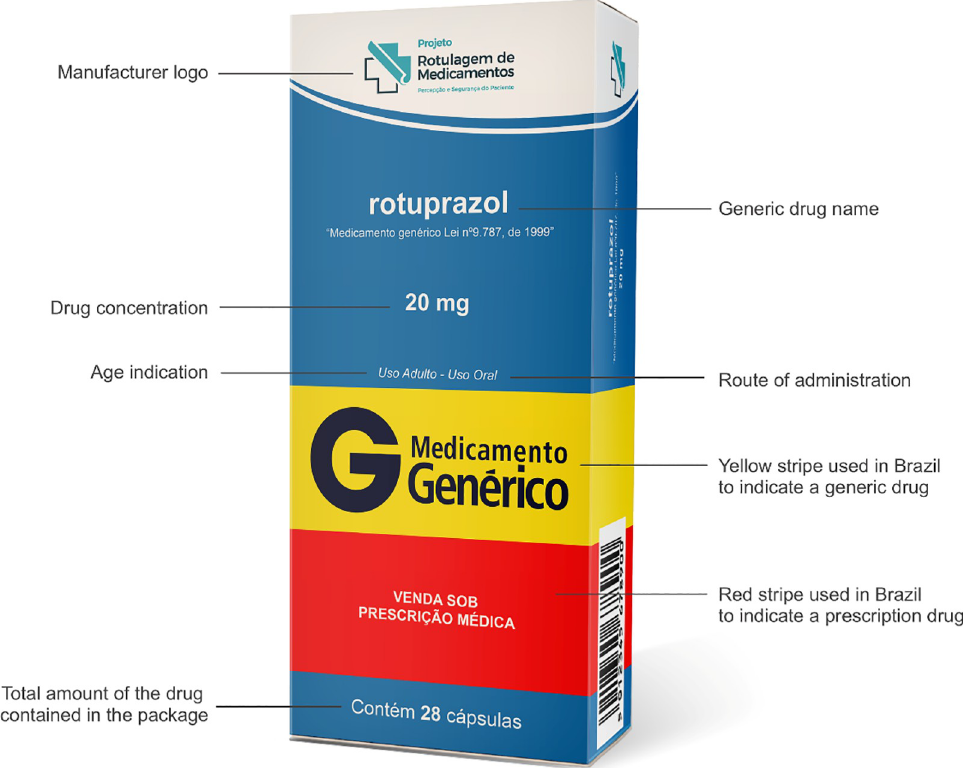
Fig 1. Simulated version of an original package currently marketed in